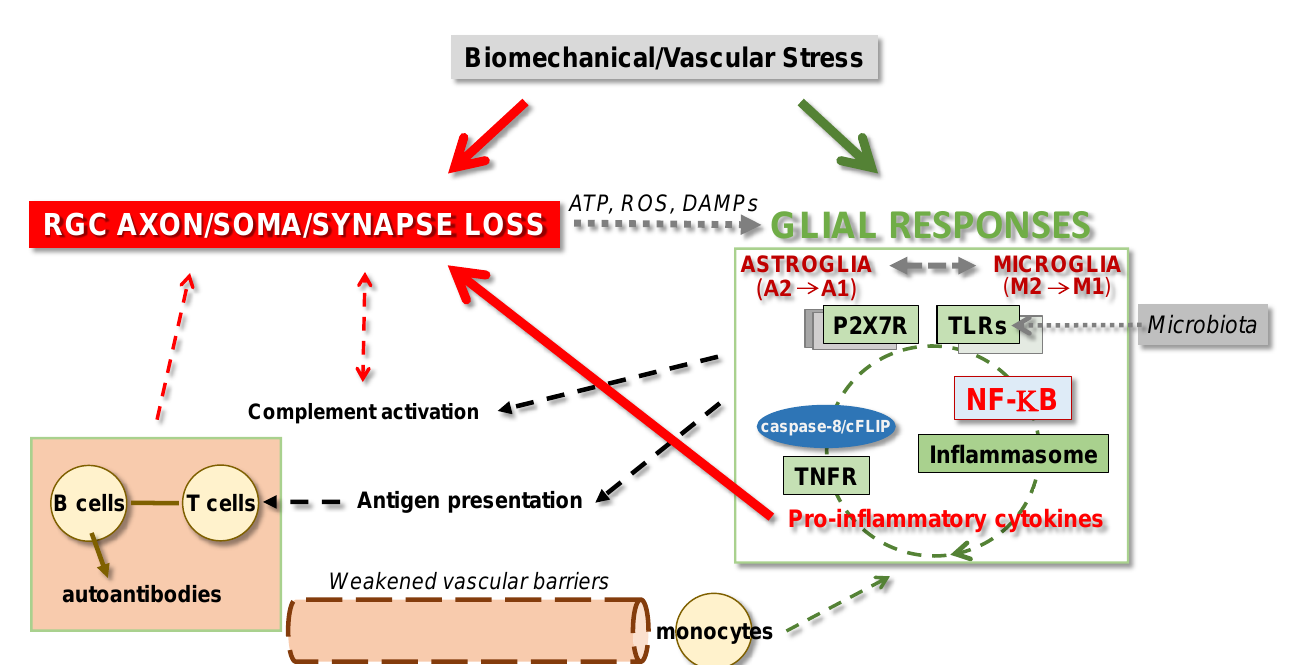
Figure 3. Glia-driven neuroinflammation can promote widespread injury to RGCs in glaucoma. Glial cells, including astroglia and microglia prominently respond to glaucoma-related tissue stress and injury. Glia can sense mechanical strain through mechanosensitive ion channels, and they can sense cellular stress by recognizing ATP, reactive oxygen species (ROS), and other damage-associated molecular patterns (DAMPs) released from RGCs. These signals stimulate inflammation through purinergic receptors (such as P2X7R), pattern-recognition receptors (such as TLRs), and inflammasome activation. Sustained release of proinflammatory neurotoxic cytokines, such as TNFα, contributes to RGC injury by activating dead receptor signaling that includes TNF receptors (TNFR). Evidently, multiple inflammation pathways activated in the glaucomatous glia are commonly regulated by the NF- κ B-mediated transcriptional program. Glial reactivities also lead to complement-mediated and adaptive immune responses with neurodegenerative outcomes. A vicious cycle of these processes may intensify the inflammatory injury of RGCs at different subcellular regions.